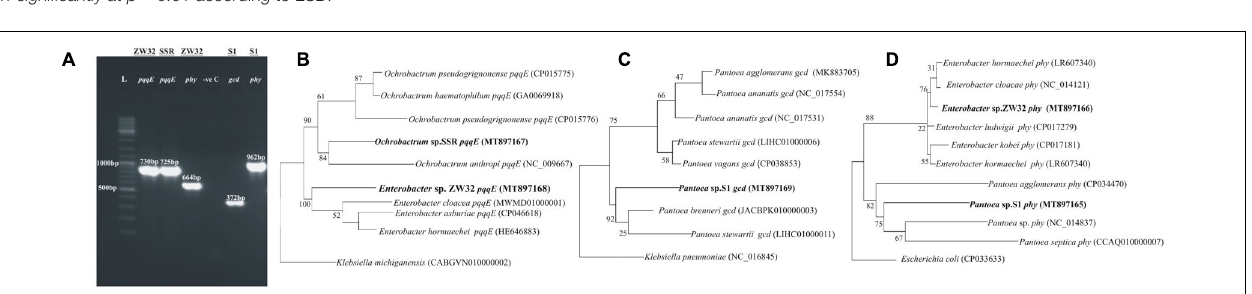
Frontiers in Microbiology |